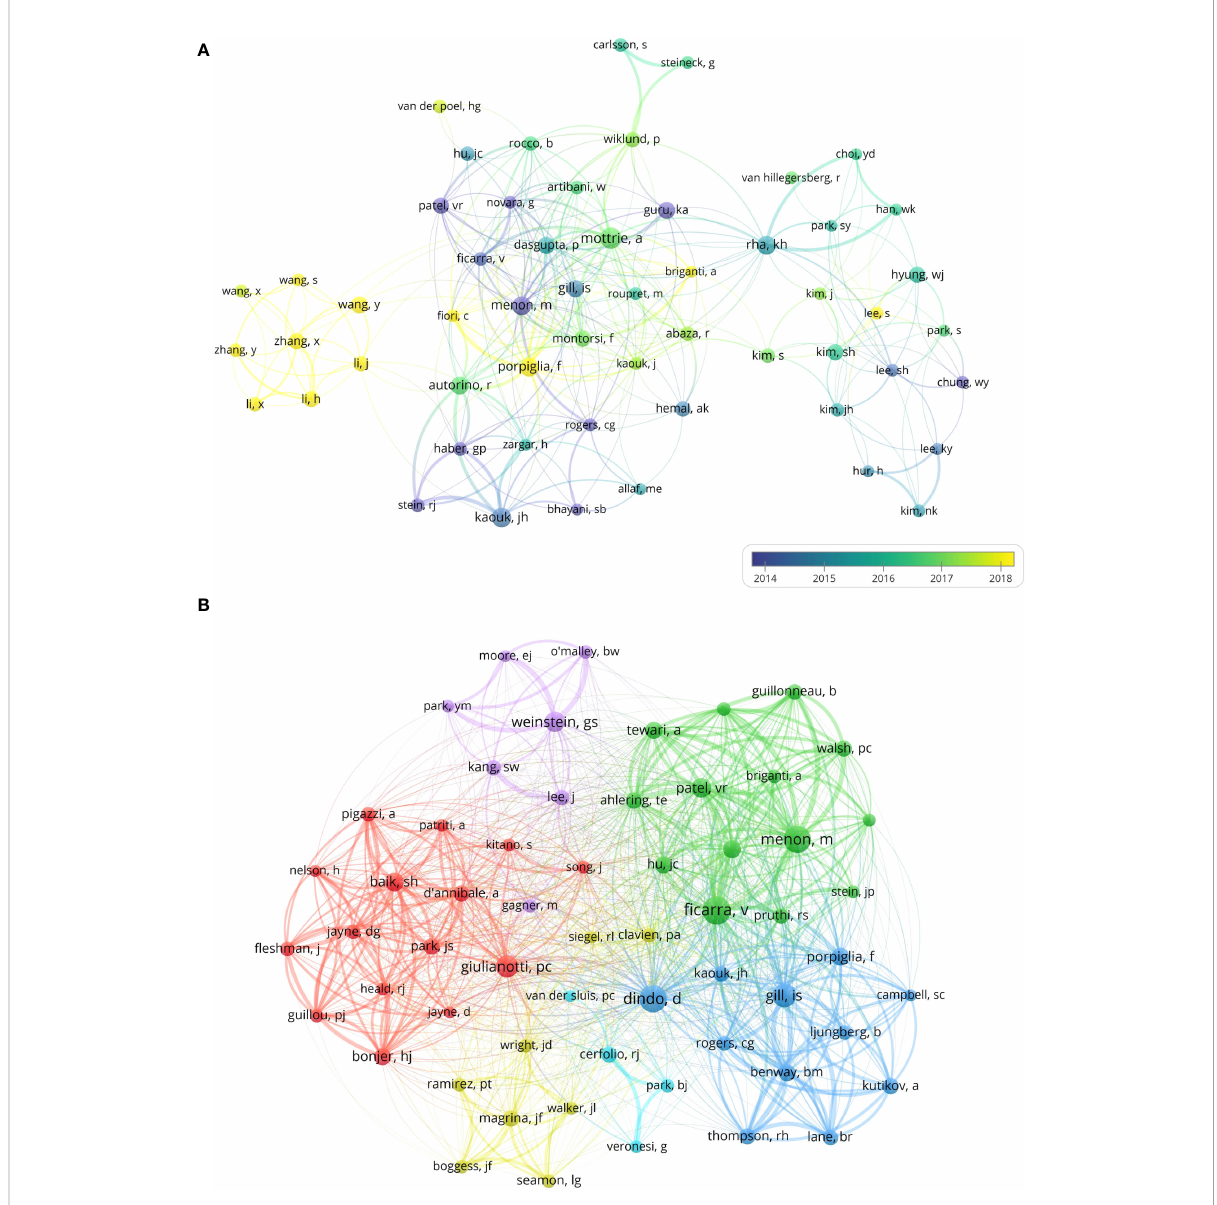
FIGURE 7 Knowledge map of authors cooperation and co-cited authors network related to robotic surgery in oncology. (A) knowledge map of authors cooperation network. The size of the nodes represents the number of papers published by the author. The warmer the color of the nodes, the later the author ’ s average publishing time. The lines between the nodes represent the cooperation between authors, and the thickness of the lines represents the strength of cooperation. (B) knowledge map of co-cited authors. The size of the nodes is proportional to the citation frequency of the author. The color of the nodes represents different clusters, and the lines between the nodes and the thickness of the lines represent the co-citation relationship and co-citation strength between authors. From: